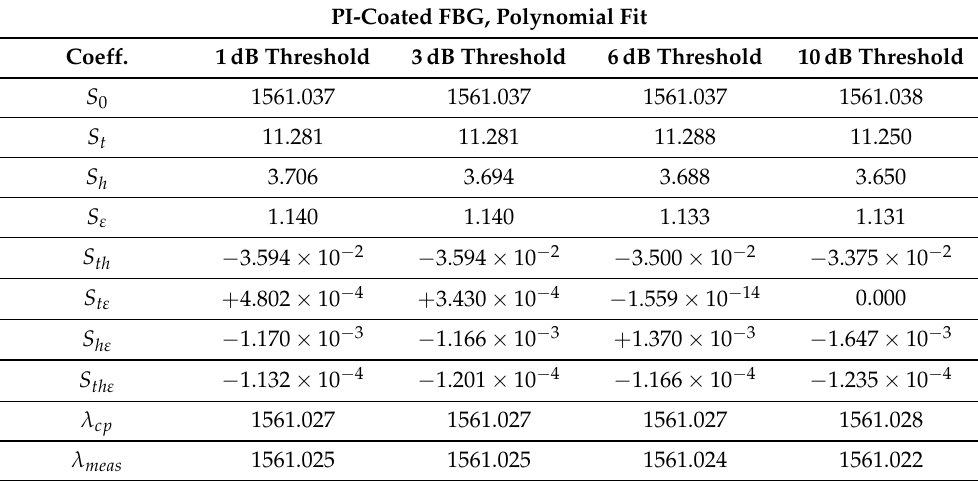
Table 5. Main and interaction sensitivities of PI-coated FBG, calculated using factorial design using polynomial algorithms.